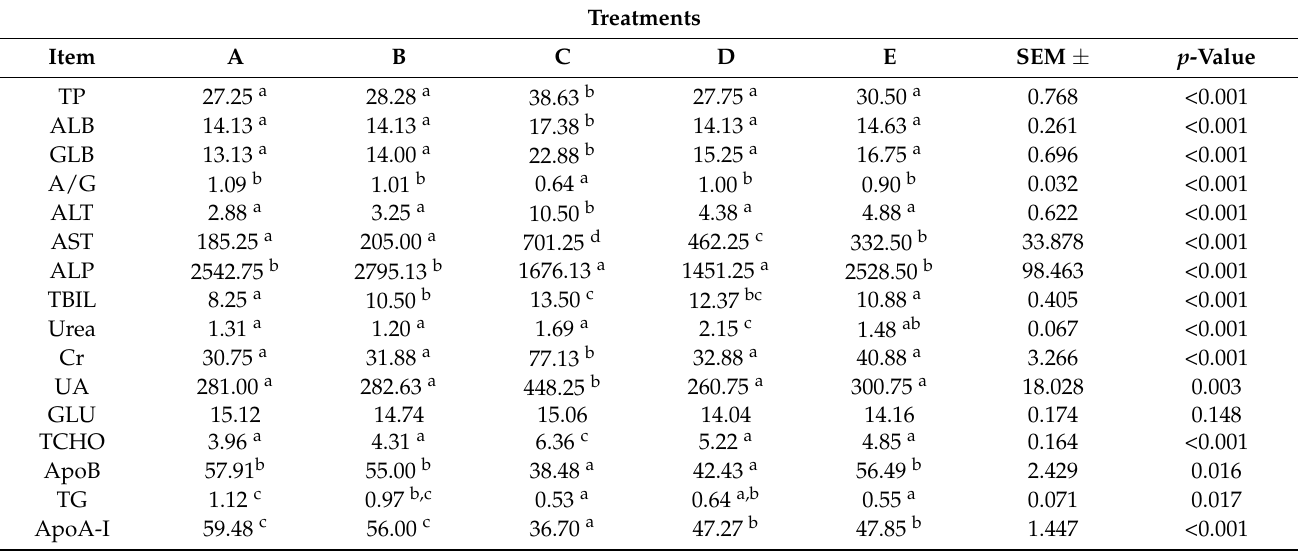
Table 8. Differences in biochemical indexes between different experimental groups. Treatments